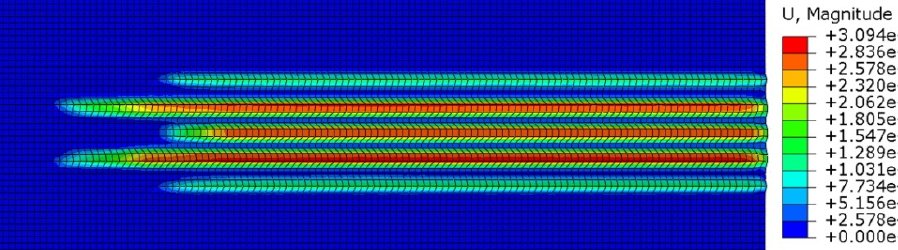
Figure 7. The whole-tooth furrow displacement.